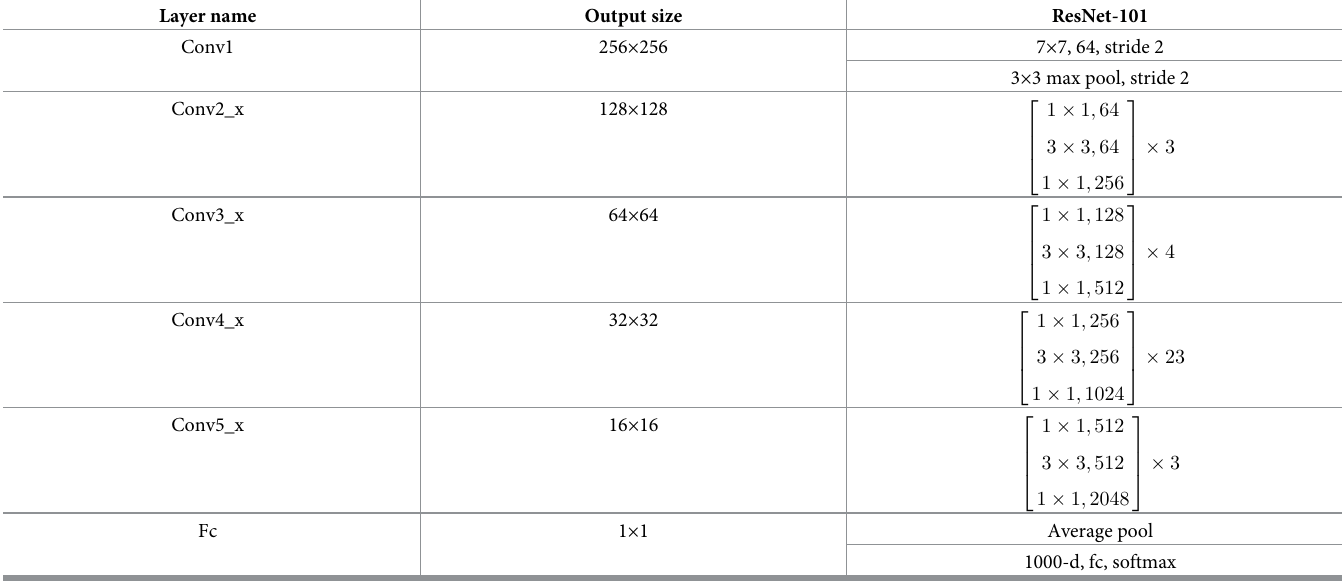
Table 1. ResNet-101 network structure table.